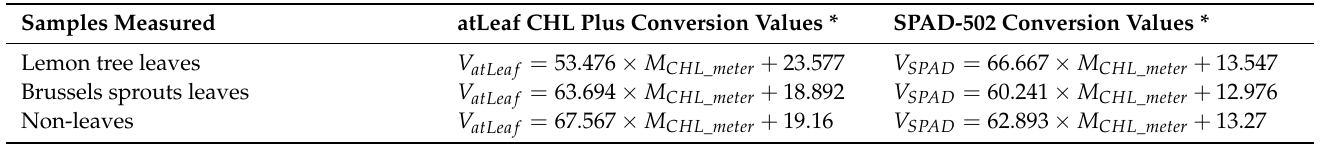
Table 4. Conversion equations to SPAD and atLeaf